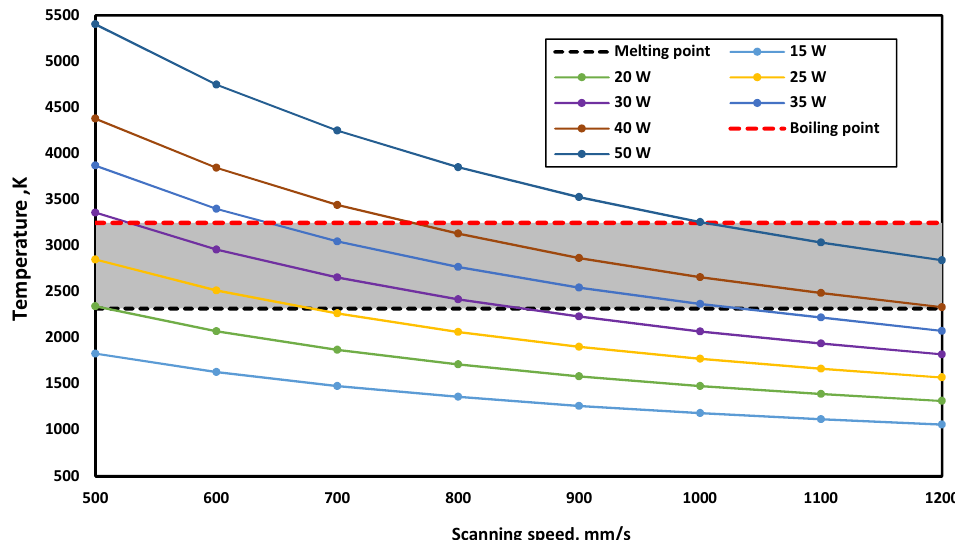
Figure 10. Obtained maximum temperature at different powers and scanning speeds using the CO 2 laser.